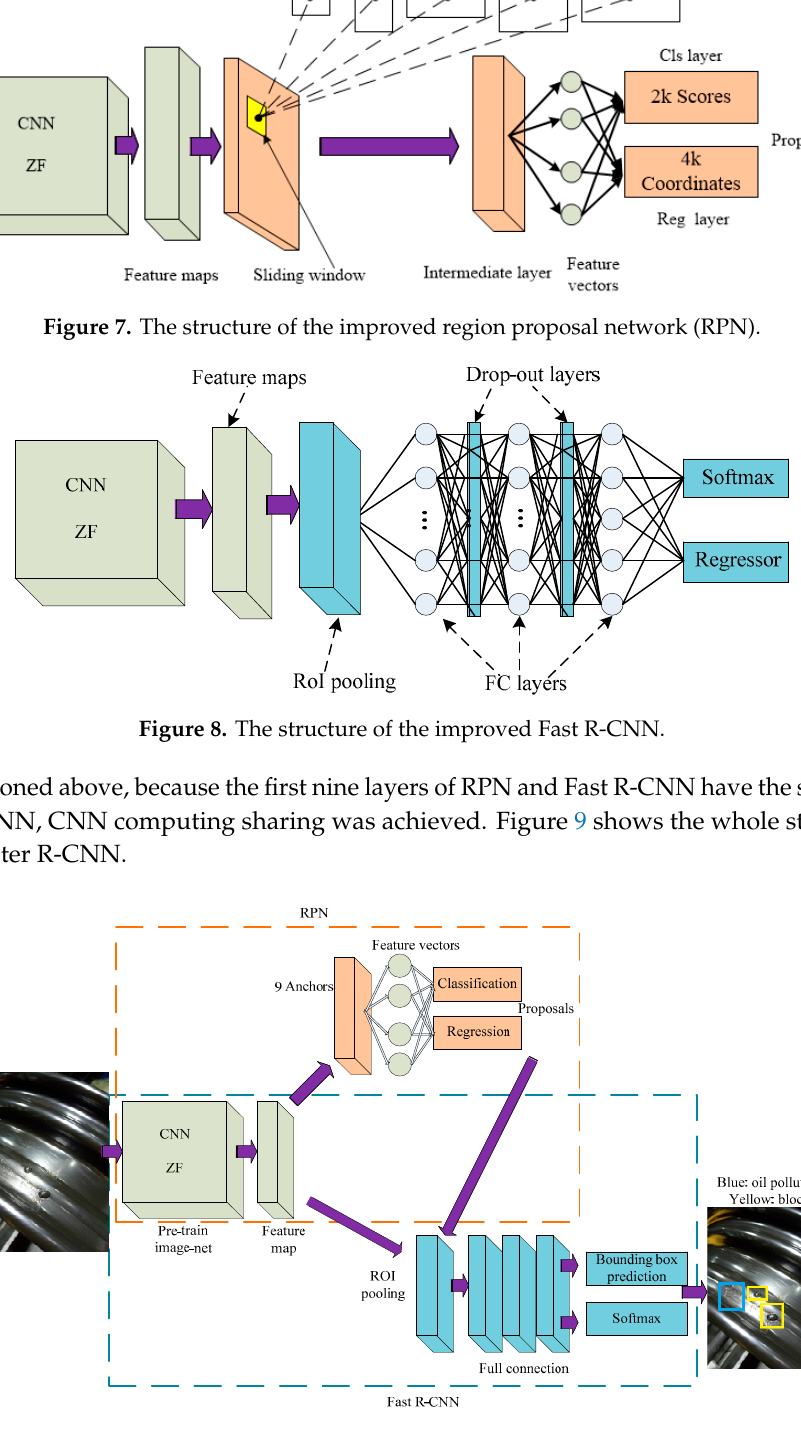
Figure 9. The structure of the improved Faster R-CNN .